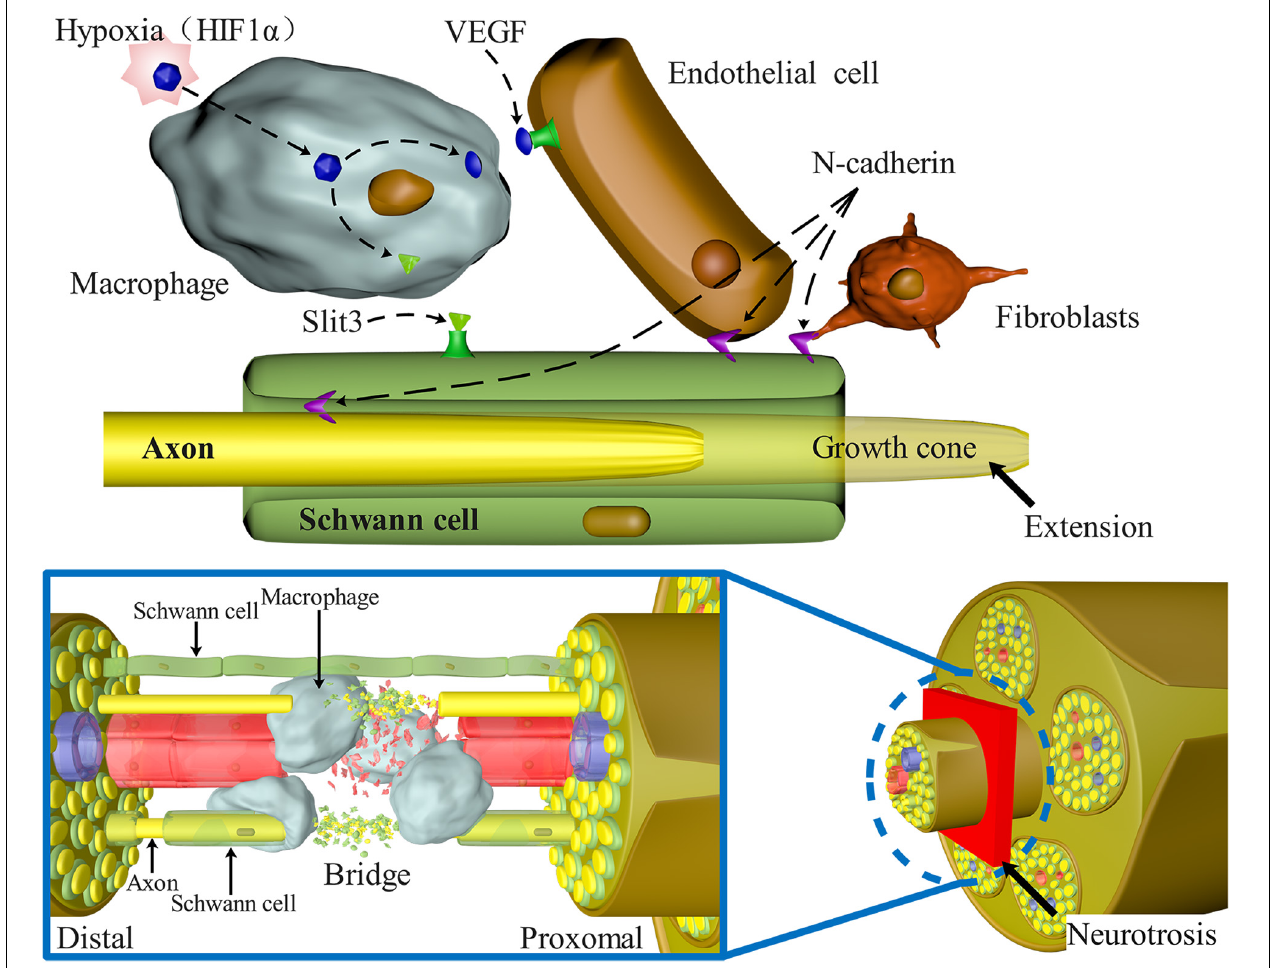
FIGURE 3 | Signaling pathways involved in SC migration, proliferation, and axon guidance in nerve bridges after peripheral nerve injury. N-Cadherin increases the adhesion between SCs, fibroblasts, and endothelial cells, causing SCs to migrate to the outside of the nerve stump and guiding axons to reorient growth at the injury site. Macrophages enter the nerve space and secrete Slit3, which binds with SCs expressing Robo1 to control the formation of correct nerve bridges and promote SC migration and axon guidance. Macrophages in the nerve bridges detect hypoxia and enhance the amount of VEGF-induced blood vessel regeneration, alleviating hypoxia, and acting as an important medium to guide axon